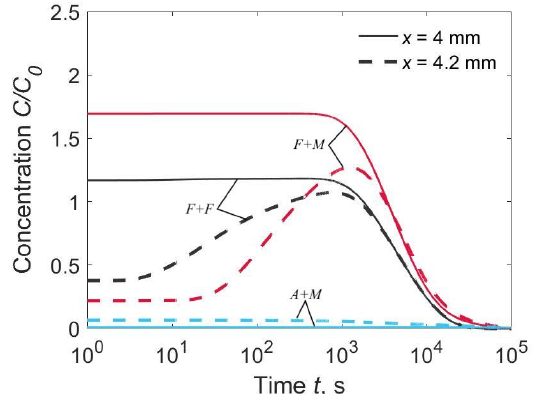
Figure 3. Time dependence of hydrogen concentration in the HAZ at the weld interface ( x = 4.0 mm) and at 0.2 mm from the weld interface ( x = 4.2 mm), C 02 /C 01 = 0.1.